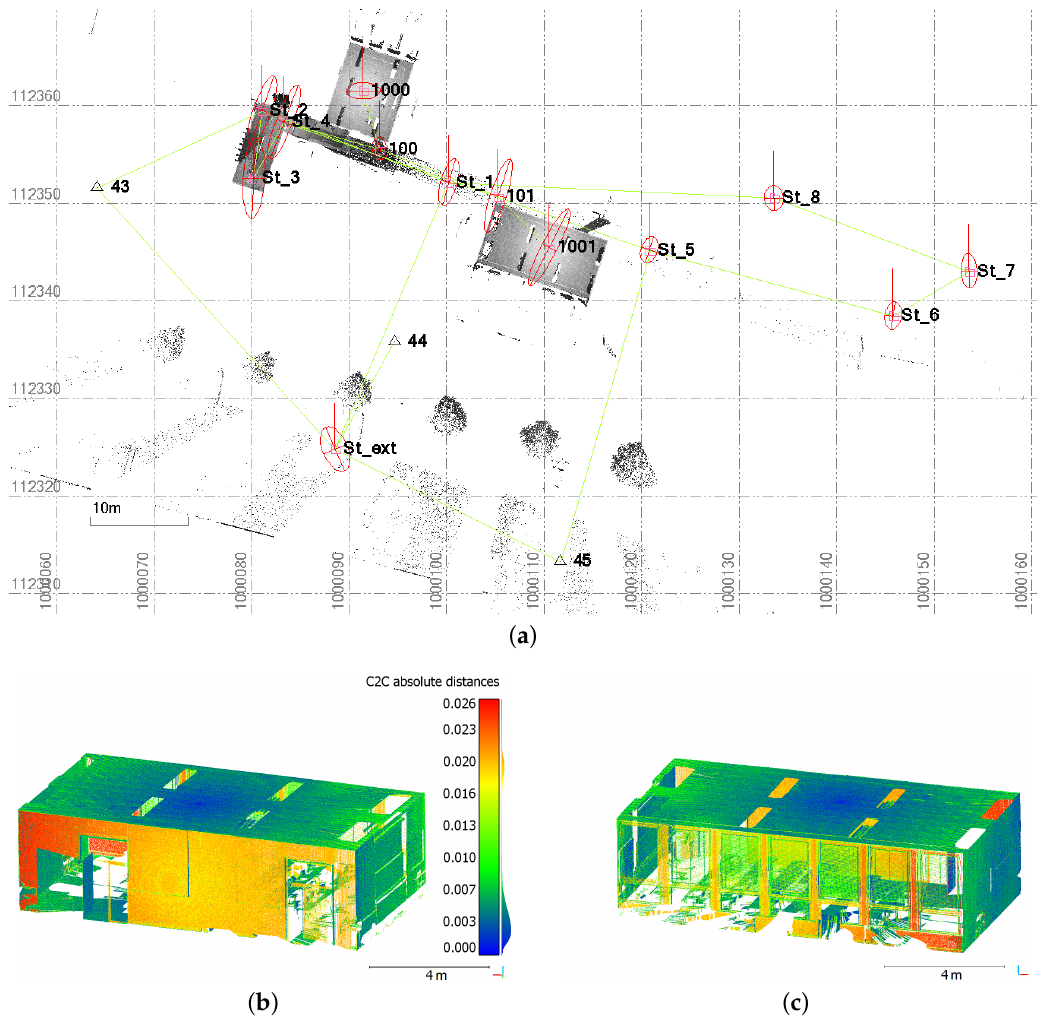
Figure 3. ( a ) Top view of the network performed within a building with error ellipsoids computed after adjustment for each network point. The point clouds acquired during this project appear in grayscale. ( b ) and ( c ): Visualization under two different views of cloud-to-cloud distances computed between point clouds of the room acquired from station 1001, before and after network adjustment. Deviations unit: